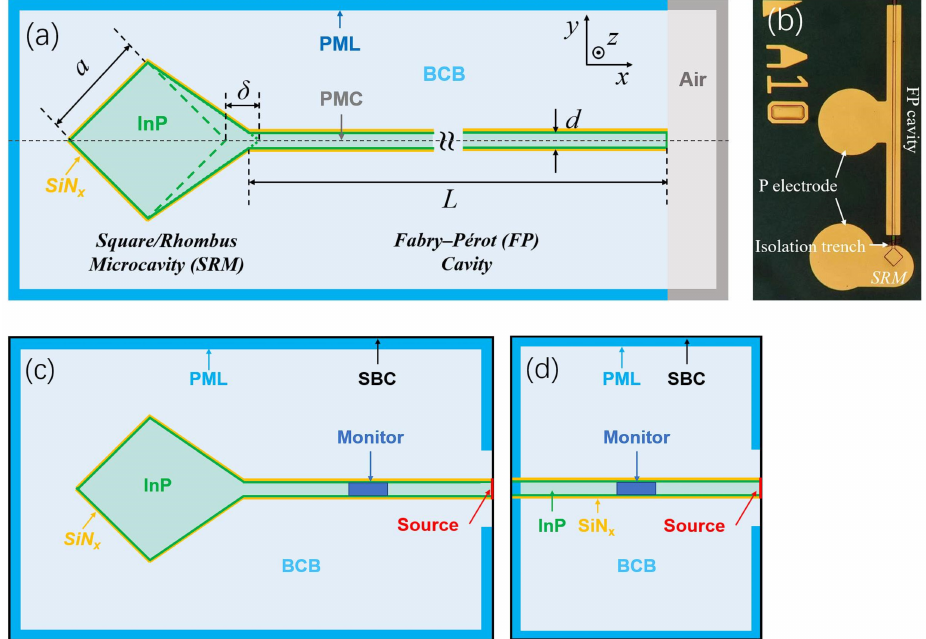
Figure 1. ( a ) Diagram of the model used for the simulation of the Q value for the coupled-cavity laser composed of an FP cavity and an SRM as a deformed square microcavity with a vertex extending a distance of δ . ( b ) Microscope image of the fabricated HSRRL. ( c , d ) Diagrams for simulating the reflection spectrum of the SRM cavity as a reflective end face in the coupled-cavity